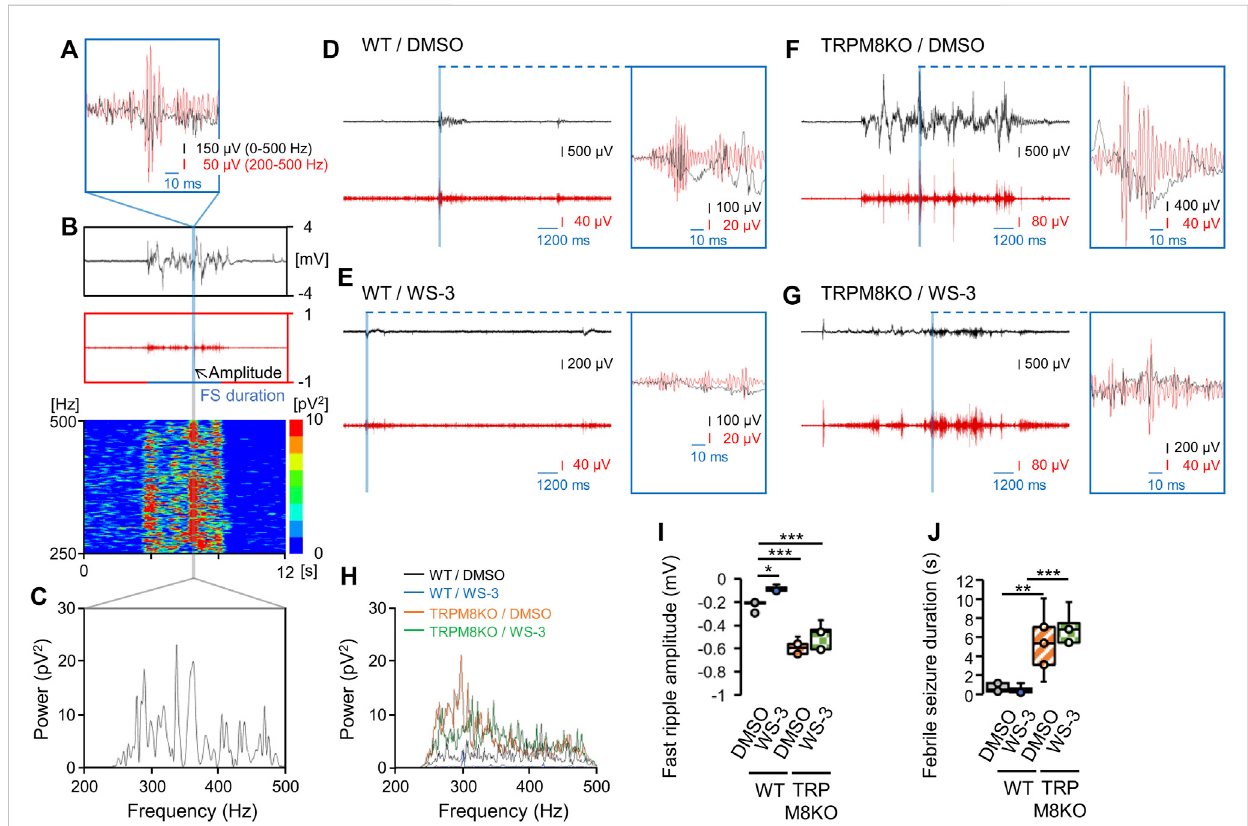
FIGURE 4 Atransientreceptorpotentialmelastatin8(TRPM8)agonistimprovedhyperthermia-induced febrileseizures(FSs),whereasTRPM8de fi ciencyledto more severe FSs. (A – C) Maximum amplitude of the fast ripple and power spectrum of the fast ripple band during the fi rst FS. (A) Example overlay of the EEG on a fast ripple spike. (B) Representative trends in the fast ripple amplitude on electroencephalogram (EEG) and fast ripple band power spectrum for the fi rstFS. (C) Examplepowerspectrumforthefastrippleband. (D – G) ExamplesofEEGandfastripples,andofEEGsoverlaidonfastripplespikes,in eachgroup. (H) Examplepowerspectraforfastripplebandsineachgroup. (I) Maximumfastrippleamplitudeforthe fi rstFSand (J) Durationofthe fi rstFS in wild-type (WT) mouse/dimethyl sulfoxide (DMSO) (white: n = 5) and WT/WS-3 (blue: n = 5) groups, and TRPM8 knockout (TRPM8KO) mouse/DMSO (orange oblique line: n = 5) and TRPM8KO/WS-3 (green squares: n = 5) groups. The results are shown as mean ± standard error of the mean. * p < 0.05, ** p < 0.01, *** p < 0.001. All analyses were followed by Tukey ’ s